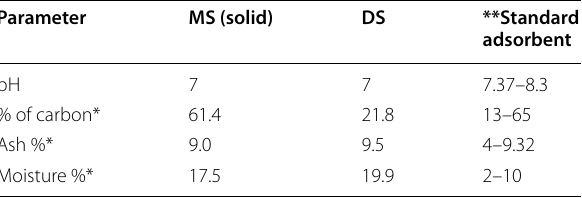
Table 2 pH, % of carbon, ash % and moisture % AC from seeds